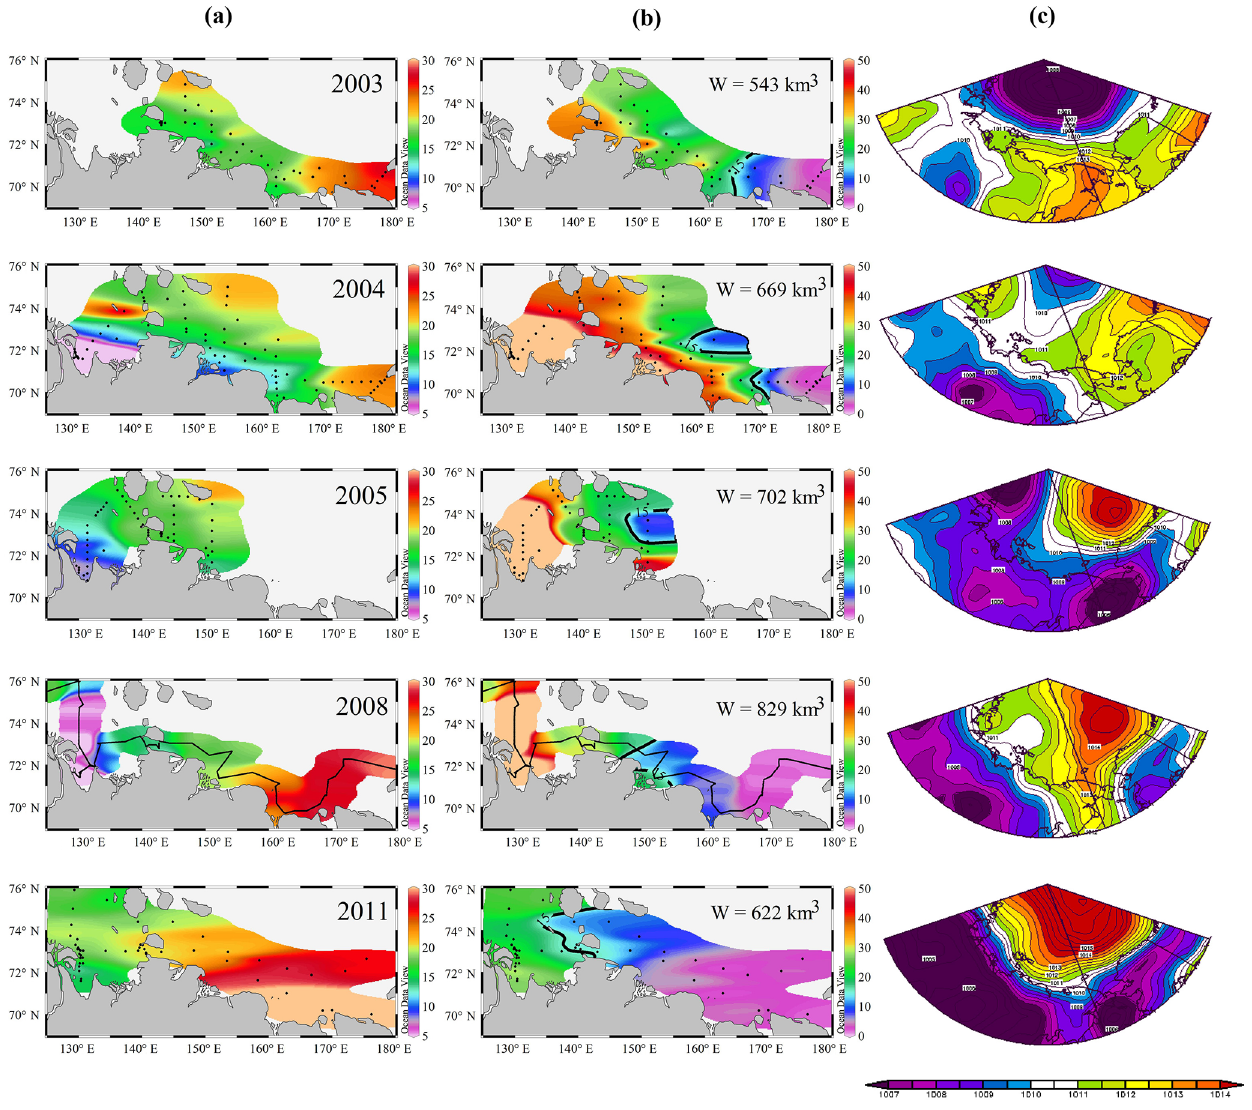
Figure 2. Distributions of surface salinity (a) and CDOM (b) in September 2003, 2004, 2005, 2008, and 2011, and (c) sea level pressure fields (mbar) averaged over the summer season (July–September) from NCEP data. W – total annual river